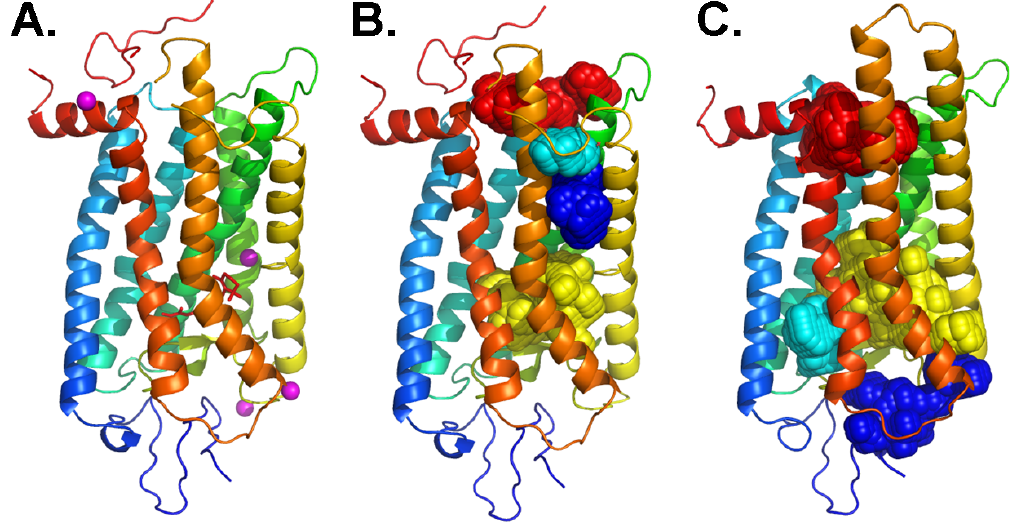
Figure 2. Crystal structures of rhodopsin showing orthosteric and allosteric binding sites. Cartoon representation of (A) rhodopsin (PDBID: 1L9H) with the different zinc binding sites, as well as (B) rhodopsin (PDBID: 1F88), and (C) opsin (PDBID: 3CAP) both highlighting the top 4 potential binding pockets predicted using Pocket-Finder tool implemented based on the Ligsite algorithm [47]. The top 1, 2, 3 and 4 predicted binding pockets are represented as spheres and colored in yellow, red, blue and cyan, respectively. The zinc metal ions are colored in magenta and rendered as spheres. The endogenous ligand 11- cis retinal is rendered as sticks and colored red in A. The N- to C-terminus of protein is colored from blue to